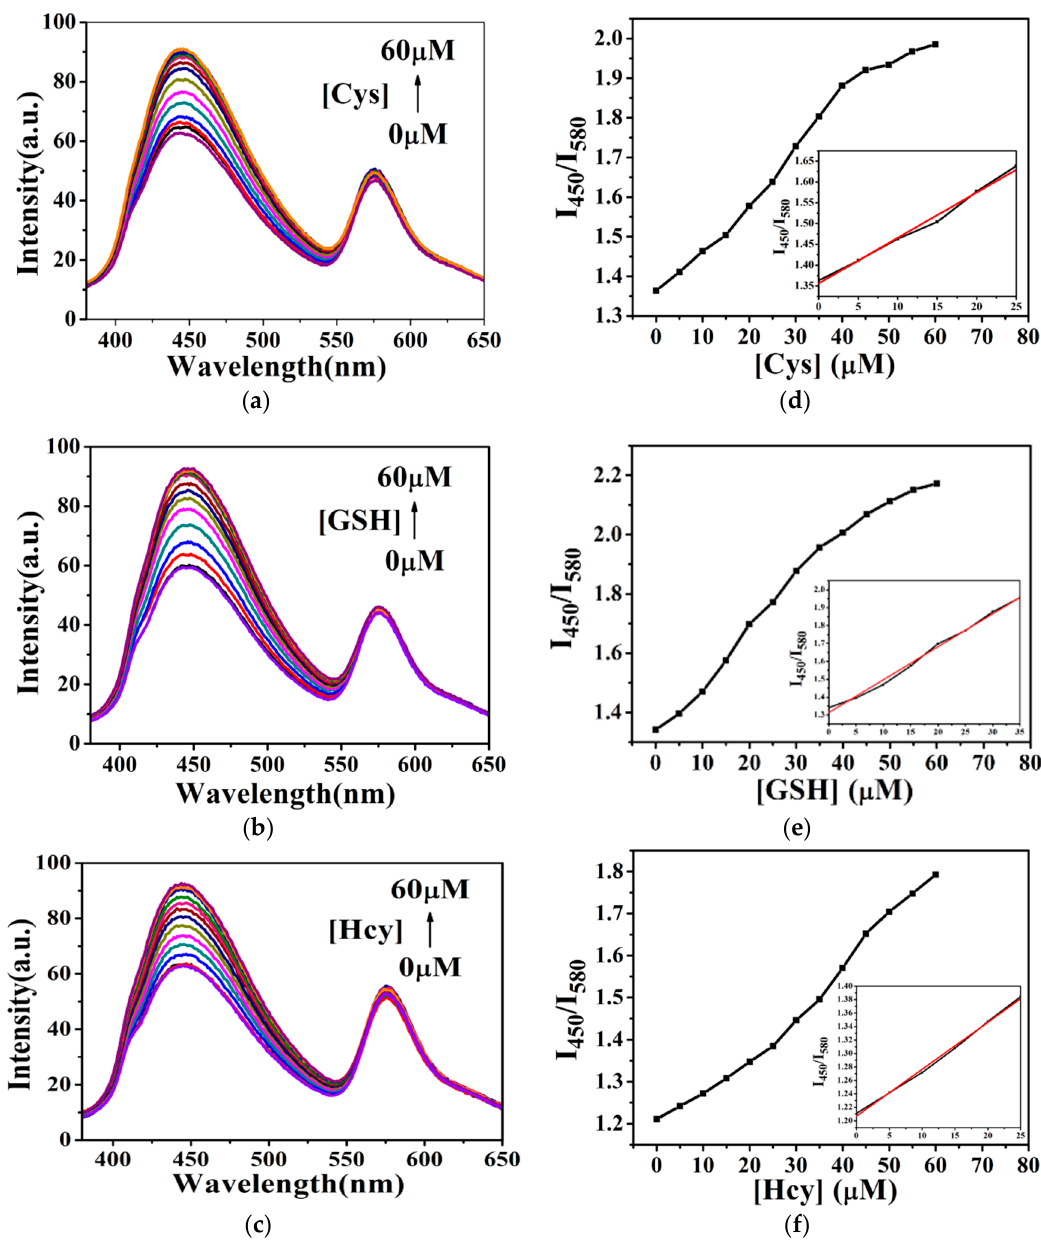
Figure 8. ( a – c ) Fluorescence spectra change of dual-emission silica microspheres upon adding different concentrations of Cys, GSH, and Hcy, after adding Hg 2+ (excited at 360 nm). The concentration of Cys, GSH, and Hcy from 0 to 60 μ M; ( d – f ) Fluorescence intensity ratio of F 450 /F 580 versus the concentration of Cys, GSH, and Hcy. Inset: linear fitting curve of F 450 /F 580 versus different concentration of Cys, GSH, and Hcy.